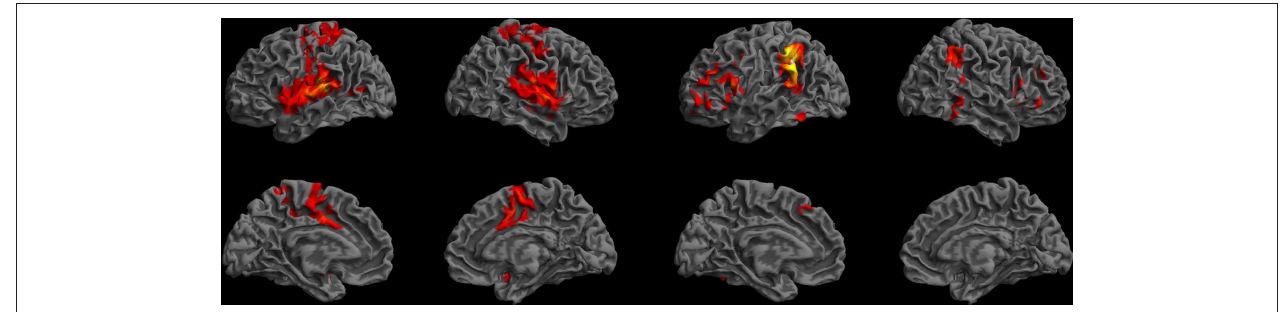
Figure 15 | resting-state functional connectivity maps for the left planum temporale (left) and the left posterior supramarginal gyrus (right) according to the Harvard–Oxford cortical atlas. These maps suggest that the network associated with the posterior MTG is distinct from the networks that include the planum temporale and the posterior SMG. Colors indicate t -values (dark red = lowest, yellow-white = highest, with the voxels within the ROI showing the highest correlation).